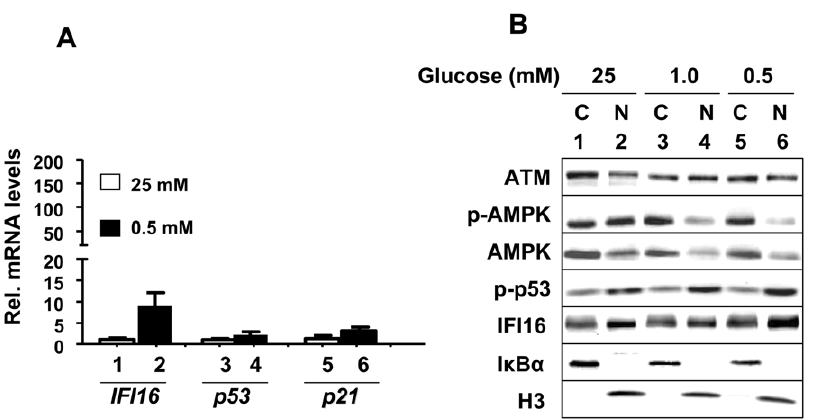
Figure 2. Glucose restriction increases steady-state levels of IFI16, p53, and p21 mRNA and increased levels of IFI16 protein are detected in the cytoplasmic and nuclear fractions. ( A ) Total RNA isolated from WI-38 cells incubated with the indicated concentration of glucose for 18 h was subjected cDNA synthesis, followed by quantitative real-time PCR using the TaqMan assay for the IFI16 , p53 , and p21 genes. ( B ) Sub-confluent cultures of HDFs were incubated with the indicated concentrations of glucose in the medium for 18 h. At the end of the incubation, cells were fractionated into the cytoplasmic and nuclear fractions as described in methods. The fractions containing equal amounts of the protein were analyzed by immunoblotting using antibodies to the indicated proteins.